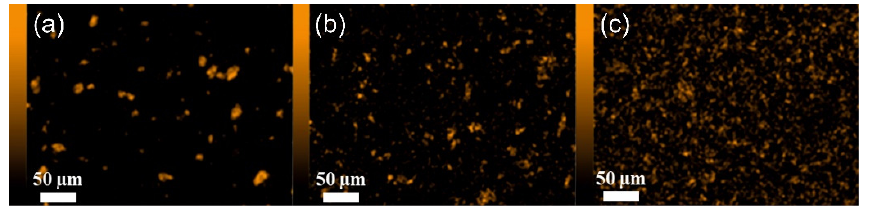
Figure 9. Surface of membranes containing POSS-Ph. Mapped Si; ( a ) PEBAX 2533 + 0.75 wt% POSS- Ph, ( b ) PEBAX 2533 + 2 wt% POSS-Ph, ( c ) PEBAX 2533 + 8 wt% POSS-Ph.